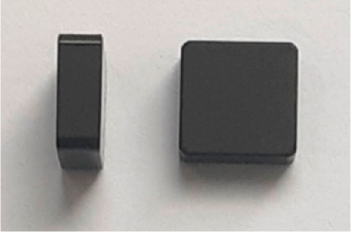
Figure 1. Photo of the nano-crystalline binderless tungsten carbide (nWC) cutting inserts.